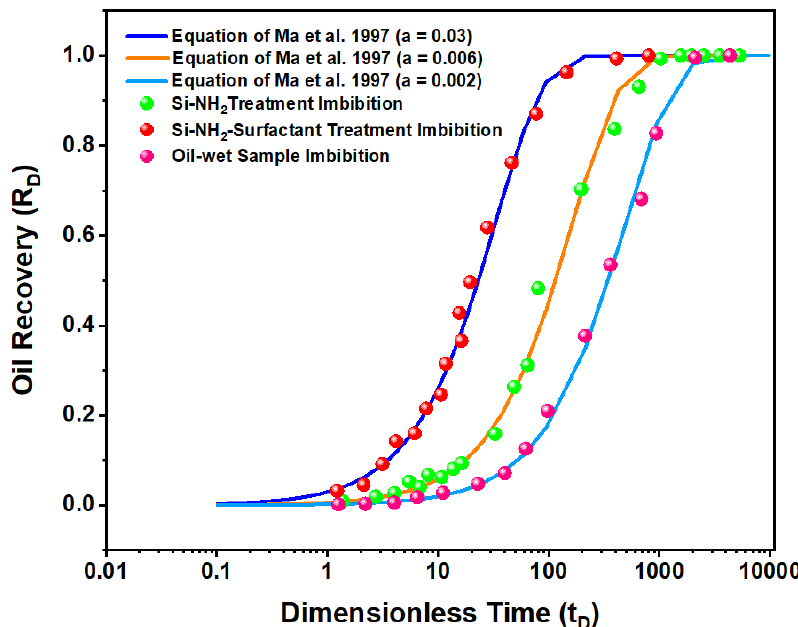
Figure 14. Imbibition oil recovery versus dimensionless time for the oil-wet sample and